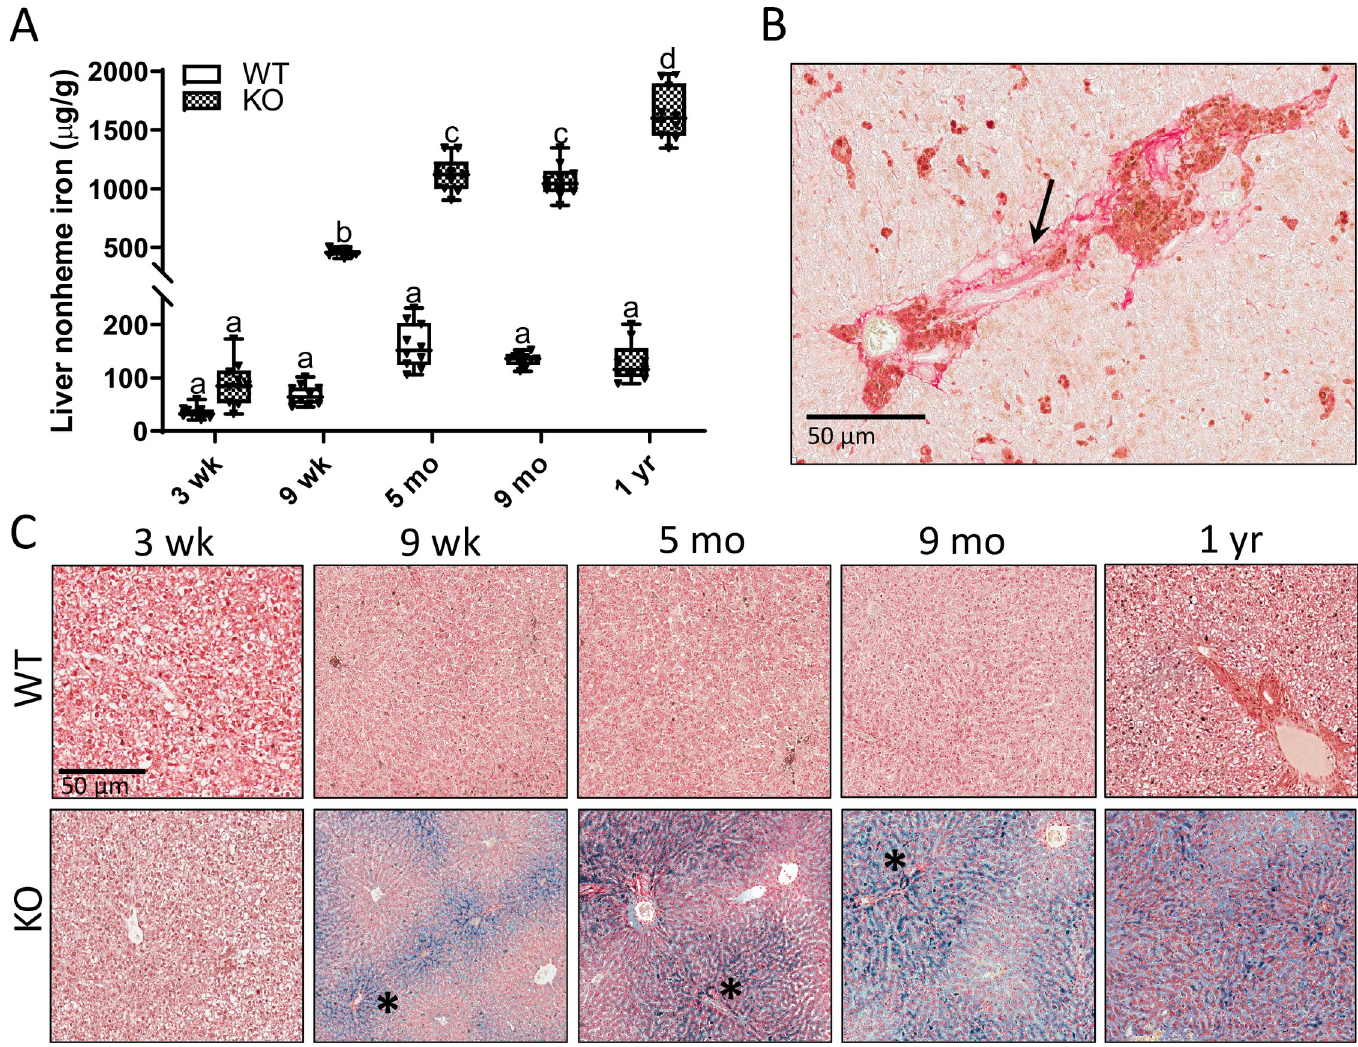
Fig 7. Progressive periportal iron loading is observed in male Hamp -/- rats. Hepatic nonheme iron levels in WT and Hamp -/- rats are shown in panel A . Data are presented as box plots for n = 9–10 animals per group. Data were log transformed before being analyzed by 2-way ANOVA followed by Tukey’s multiple comparisons test; however, untransformed data are presented for ease of interpretation. Groups without a common letter differ significantly ( p < 0.0001). Genotype × Age, p < 0.0001; Genotype, Age, p < 0.0001. An example picro-sirius red staining image of a liver section from a 1-year-old male Hamp -/- rat is also shown ( B ). The arrow indicates a fibrotic region (i.e., collagen fibers). Fibrosis was infrequently observed in the livers of older KO rats. Representative images of liver sections from WT and Hamp -/- rats stained with Perls’ Prussian blue are also shown ( C ) (n = 6 per group). Asterisks demarcate portal triads.